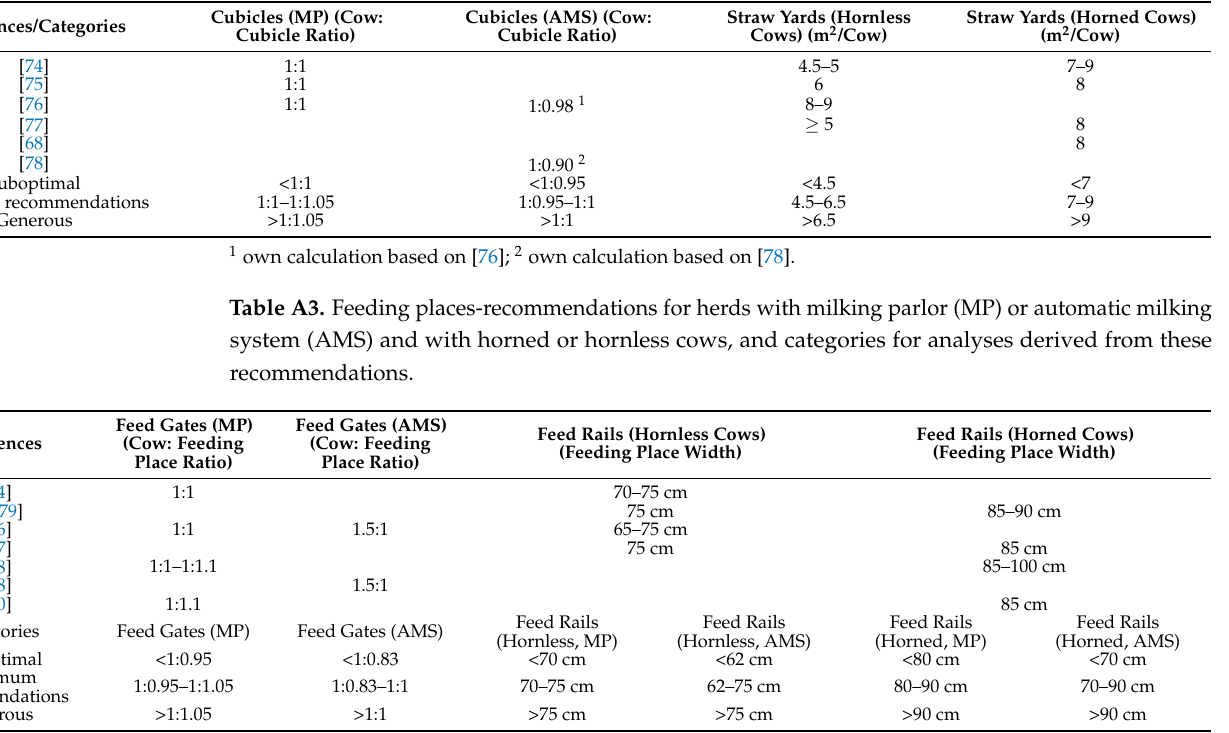
Access to Outdoor Run Fixation for Feeding